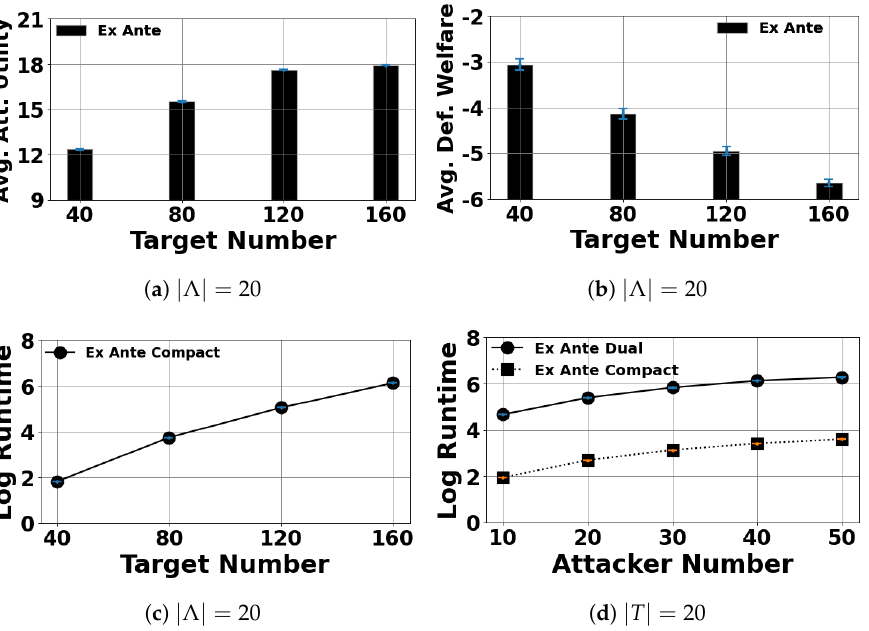
Figure 6. Scalability of target number or attacker types in ex ante setting when | D | = 4 and the defenders’ cost range C d ( t ) ∈ [ 0,10 ]